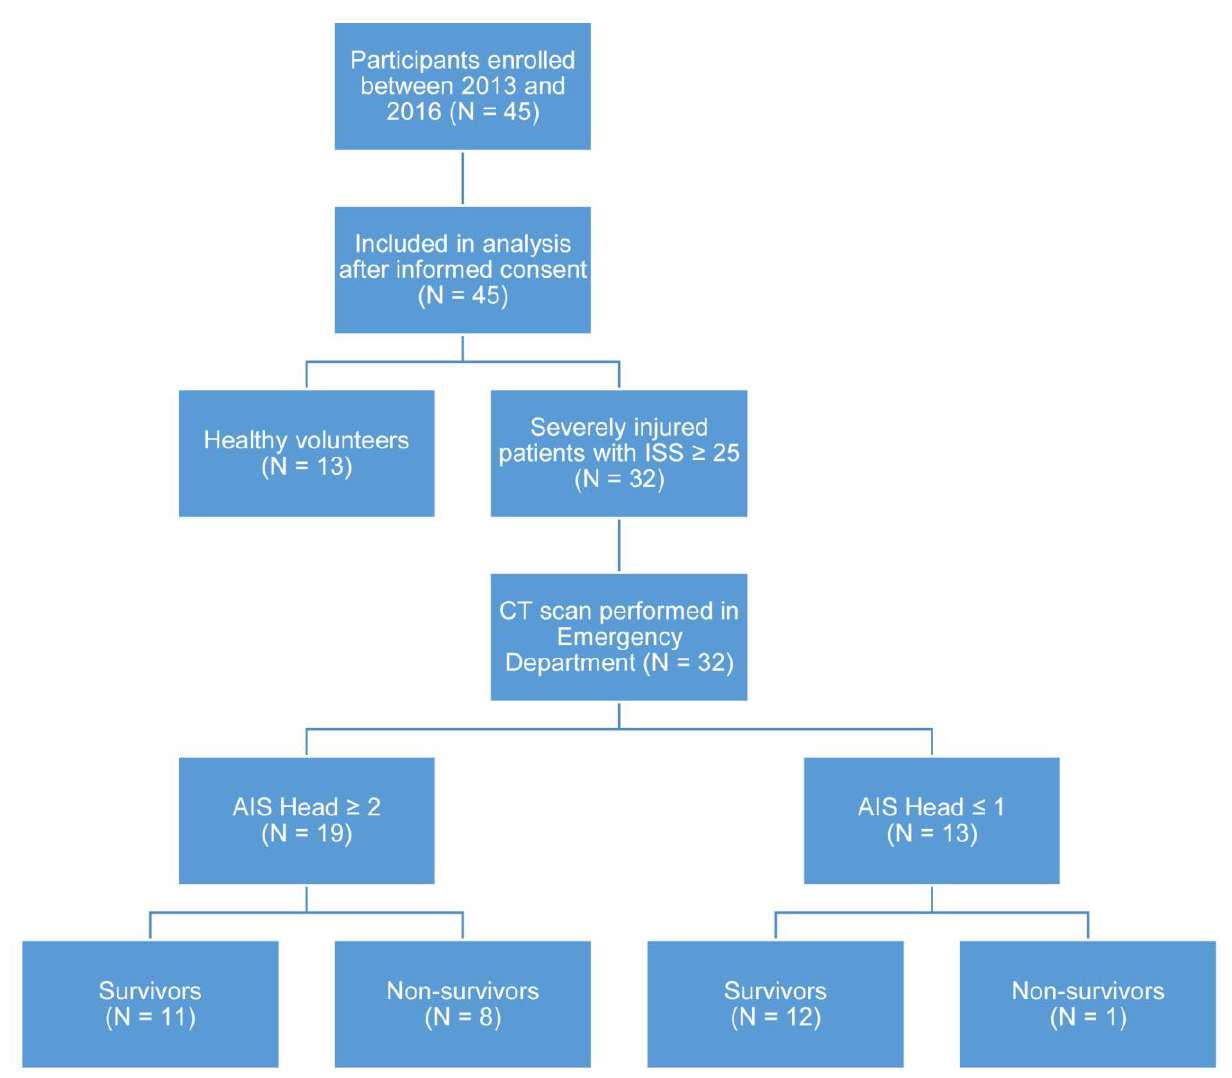
Figure 6. Flow chart of enrolled participants. AIS, abbreviated injury score; CT, computed tomography; ISS, injury severity score.